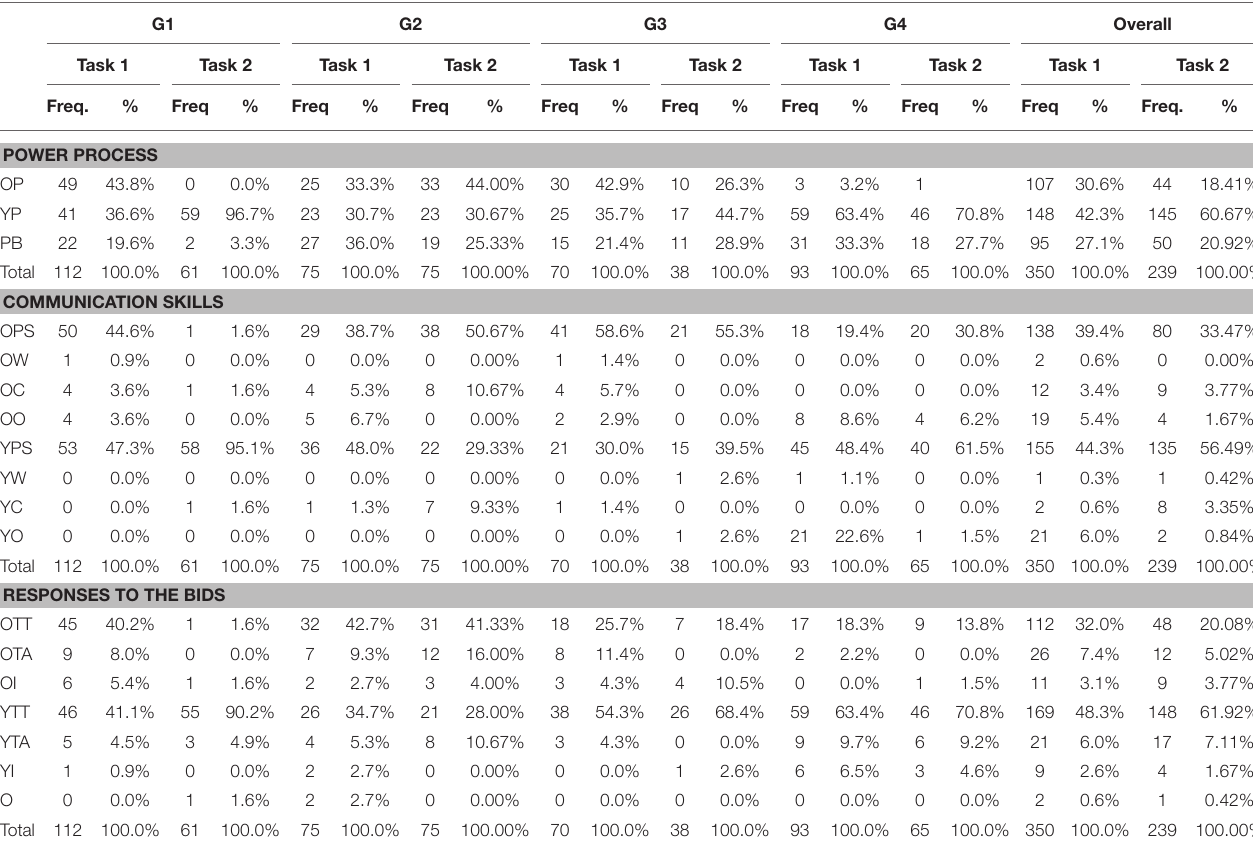
TABLE 3 | Frequencies and percentages of each interaction code during the